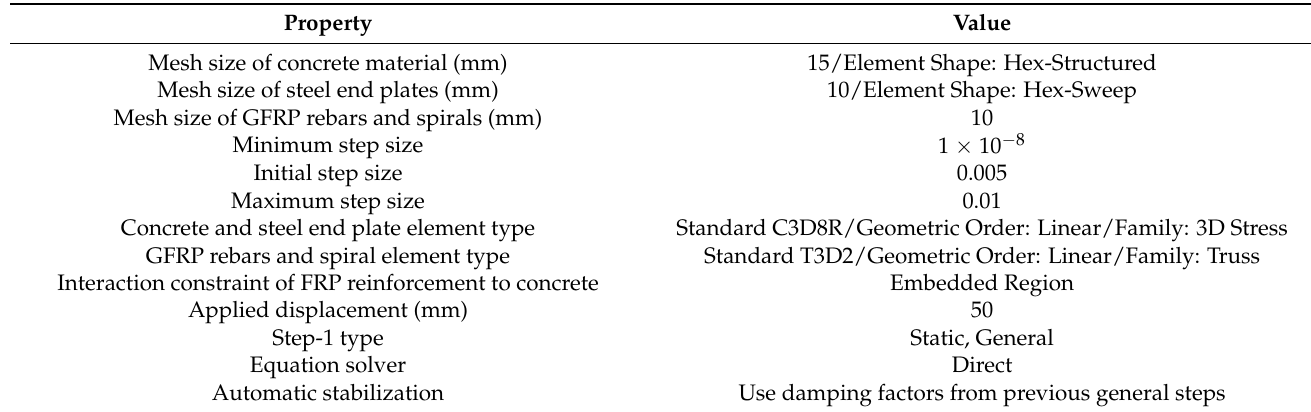
Table 3. Properties of finite element (FE)